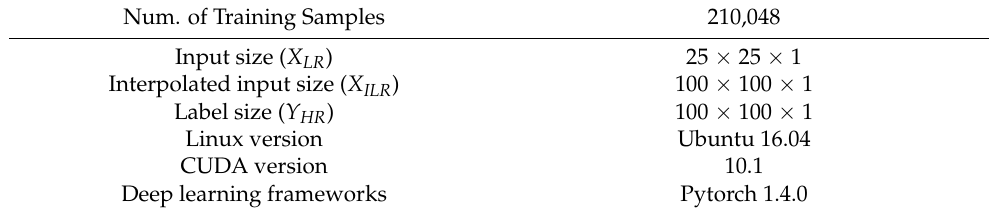
Table 5. Experimental environments.